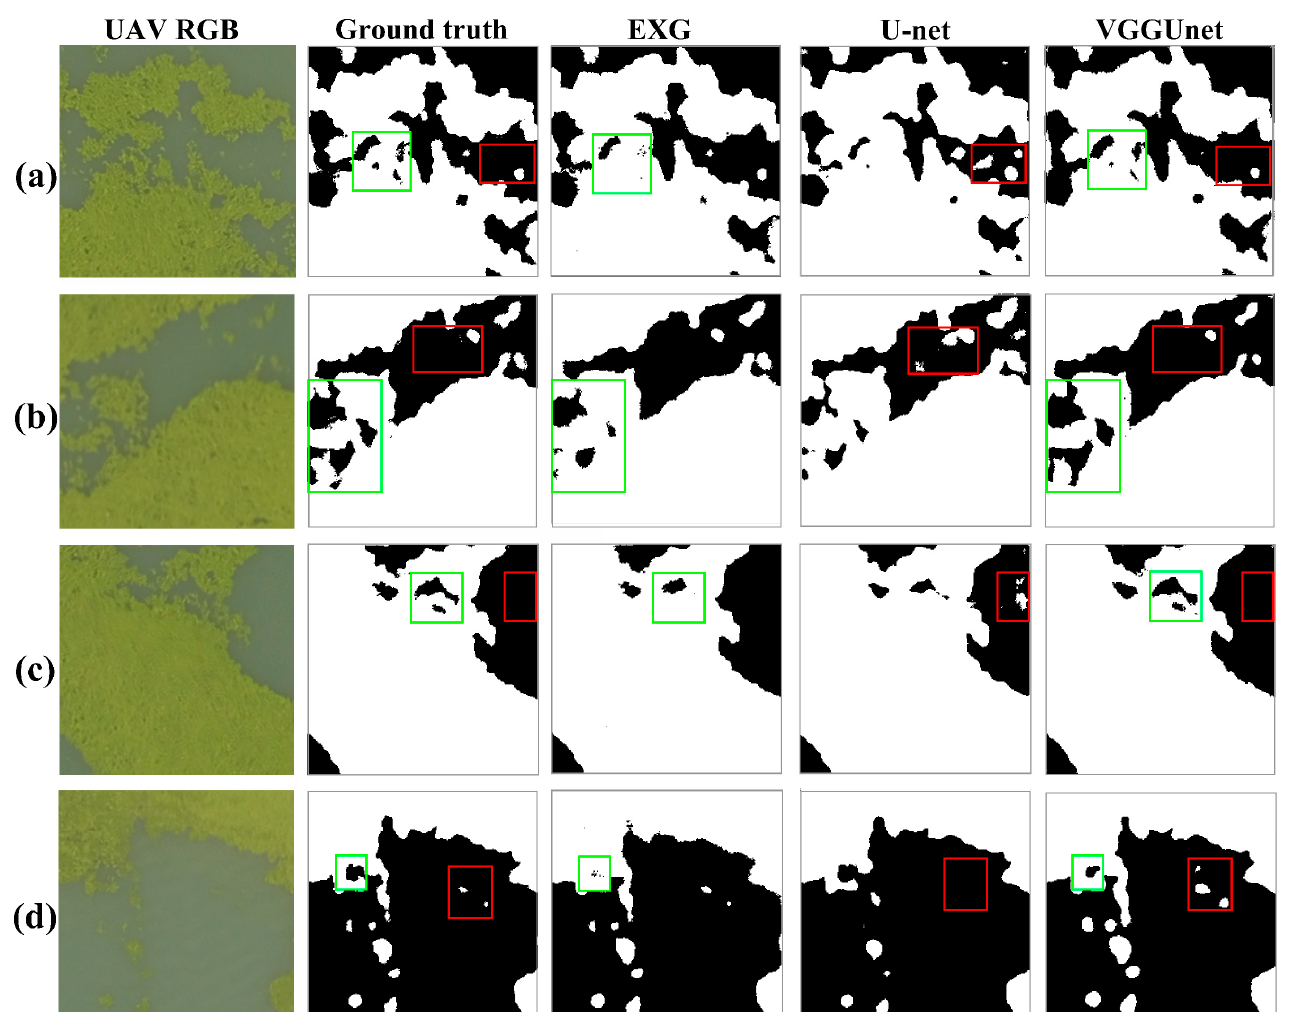
Figure 6. Comparison of U. prolifera extraction results from EXG, the U-net model, and the VGGUnet model on UAV images. ( a – d ) Five test images: the UAV RGB image, the ground truth image, the U. prolifera extraction result from EXG, the U. prolifera extraction result from the U-net model, and the U. prolifera extraction result from the VGGUnet model. The key parts of the comparison between NDVI and the ground truth and the VGGUnet model are shown in red rectangles, while those between the U-net model and the ground truth and the VGGUnet model are shown in green rectangles.